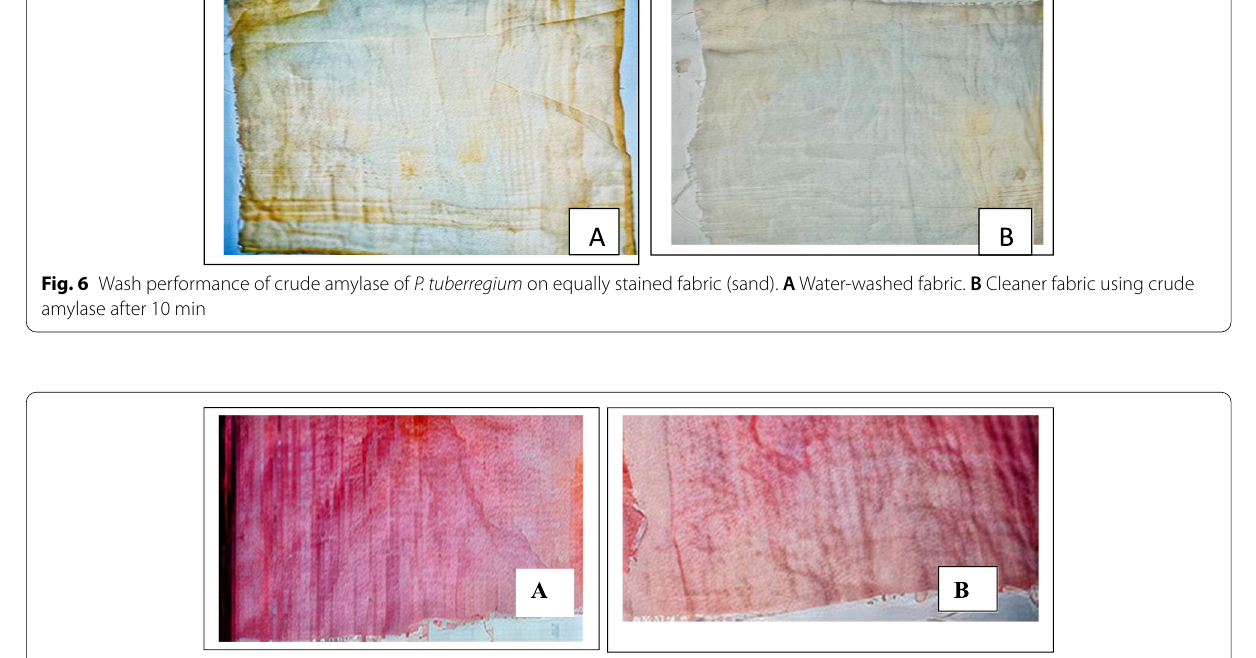
Fig. 7 Wash performance of crude amylase on equally stained fabric (ink). A Water-washed fabric serving as the control. B Partially washed fabric with crude amylase after 10